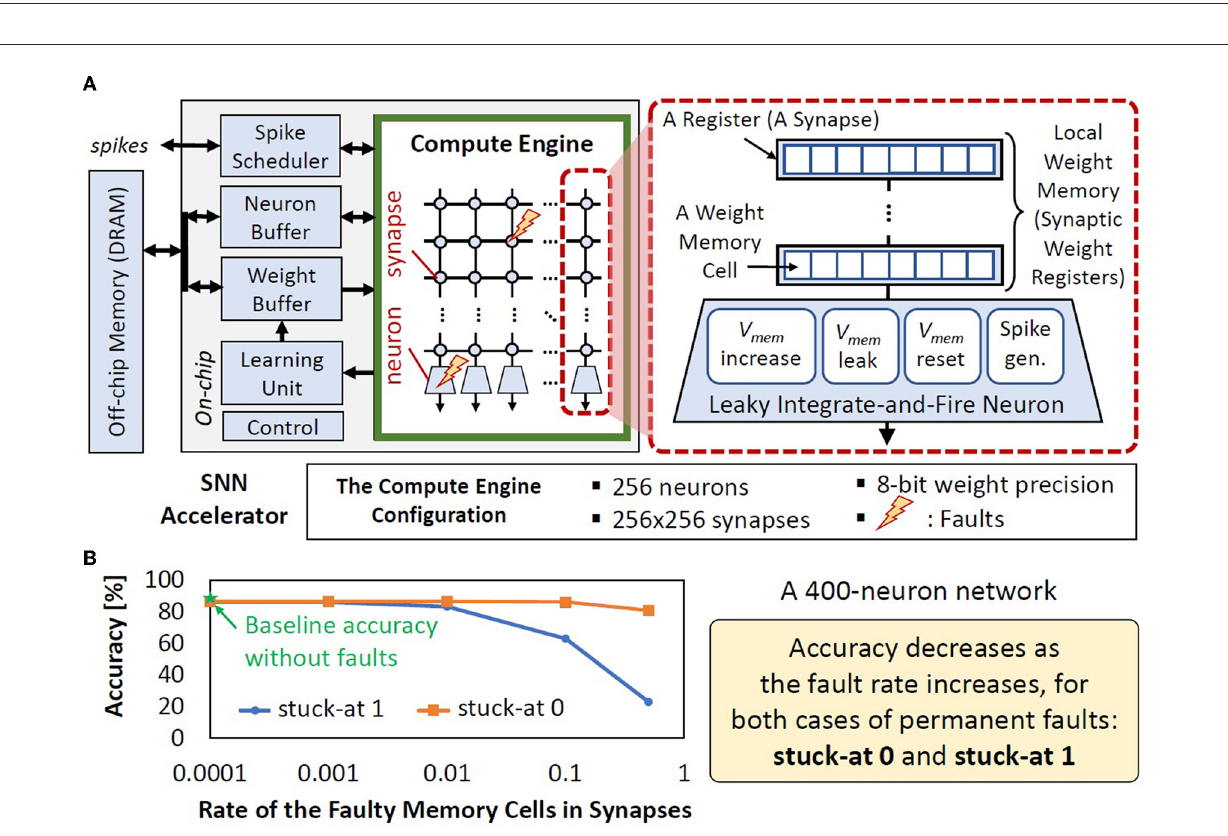
FIGURE2 (A) The typical SNN accelerator architecture employs crossbar-based synaptic connections (Basu et al., 2022). Synapses and neurons can be affected by permanent faults, whose detailed discussion is provided in Section 2.2. (B) The stuck-at faults in the local weight memory (synaptic weight registers) can decrease